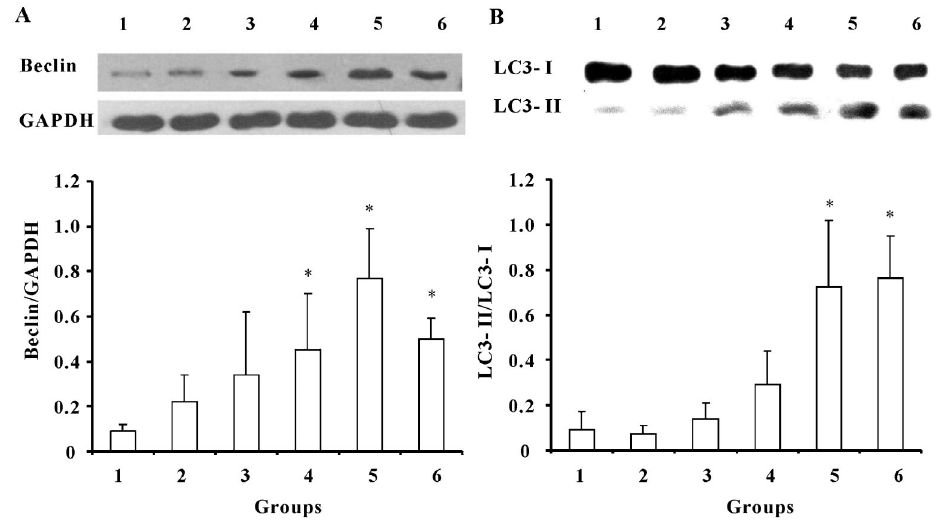
Figure 2. Ischemic preconditioning (IPC) activates autophagy in rats undergoing ischemic reperfusion (I/R) 24 h post-ischemic injury. A , IPC increased Beclin expression. B , IPC increased LC3 conversion. Data are reported as means±SE of 4 rats in each group. Groups: 1) sham control, 2) I/R, 3) 5 min IPC++I/R, 4) 5 6 5 min IPC++I/R, 5) 5 6 5 6 5 min IPC++I/R, and 6) 15 min IPC++I/R. *P , 0.05, compared to I/R group (one-way ANOVA followed by the Bonferroni